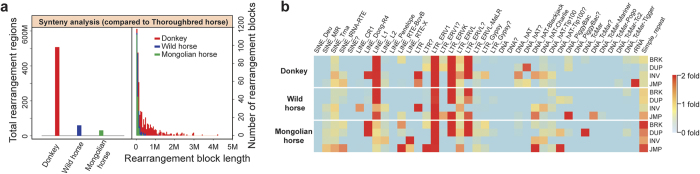
Whole genome synteny analysis.Comparisons of the donkey, wild horse and Mongolian horse genomes to the Thoroughbred horse genome. (a) The number of rearrangement blocks in donkey, wild horse, Mongolian horse genomes with respect to the Thoroughbred genome. (b) The content of some repetitive sequences significantly increased in rearrangement regions compared with the collinearity region.